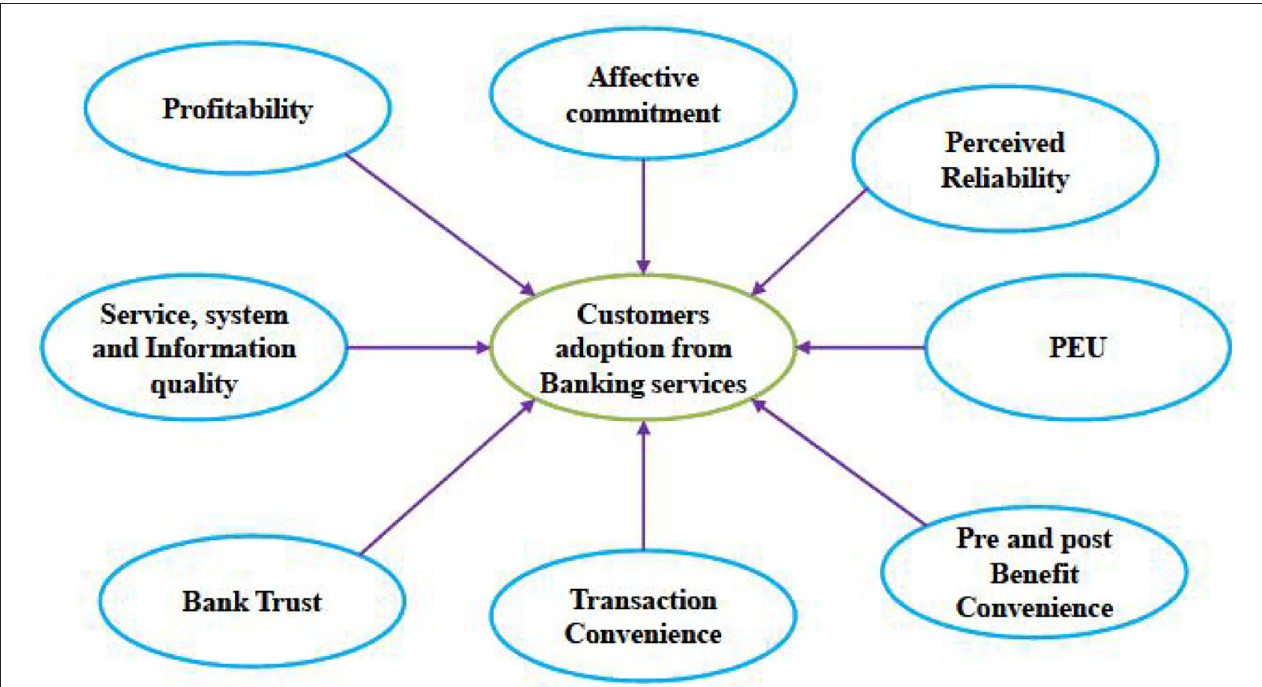
FIGURE 2 | Conceptual modeling